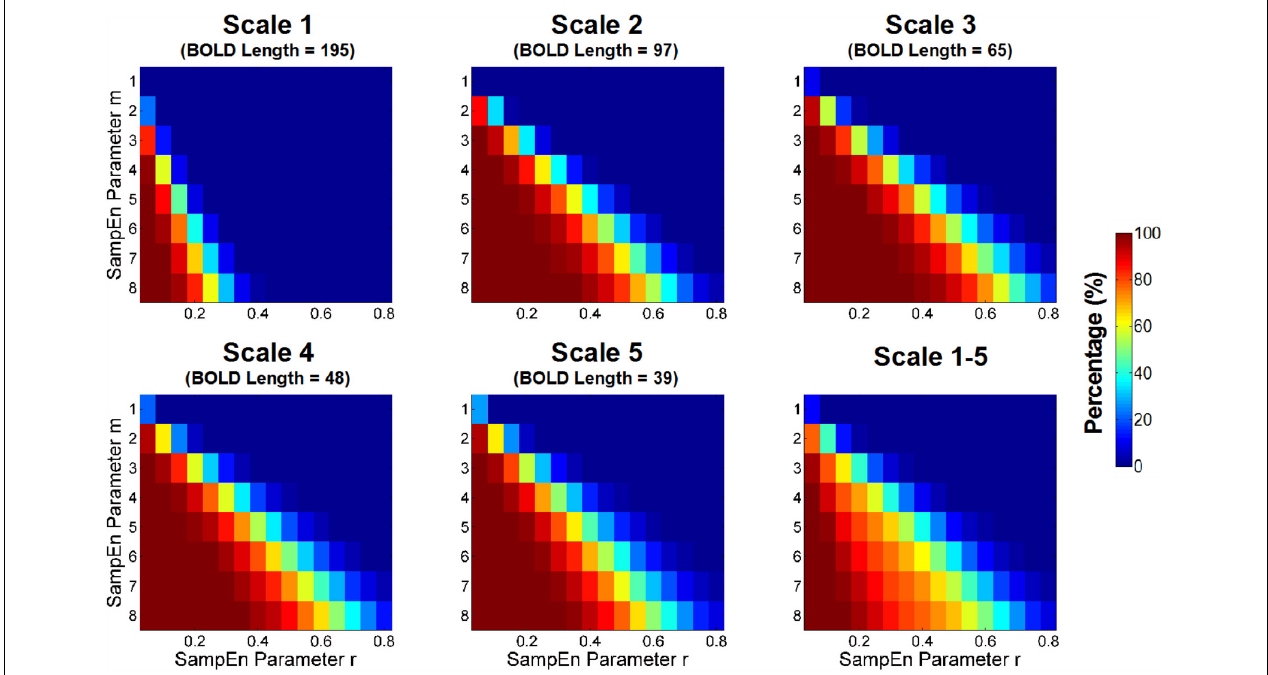
FIGURE 3 | Percentage of estimation failure for sample entropy (SampEn) because of the absence of pattern matches in CSF BOLD signals. The percentage was calculated based on the CSF voxels with invalid SampEn relative to all CSF voxels in the entire study cohort. The percentage was compared with those of various combinations of m and r across all scale factors with different BOLD signal lengths. The more stringent combinations of m and r (i.e., higher m and lower r ) and shorter BOLD signals resulted in a higher percentage of invalid SampEn estimations. Ideally, the choice of m and r should have valid SampEn estimations in all